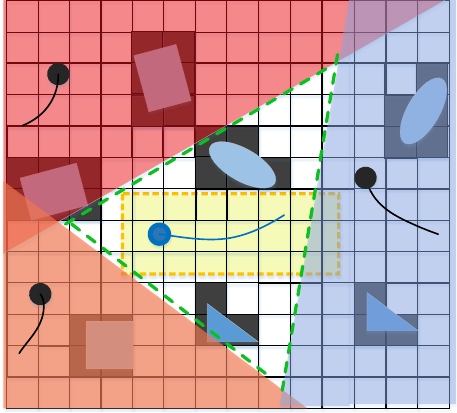
Figure 7. Model predictive priority contouring control with double-layer corridors